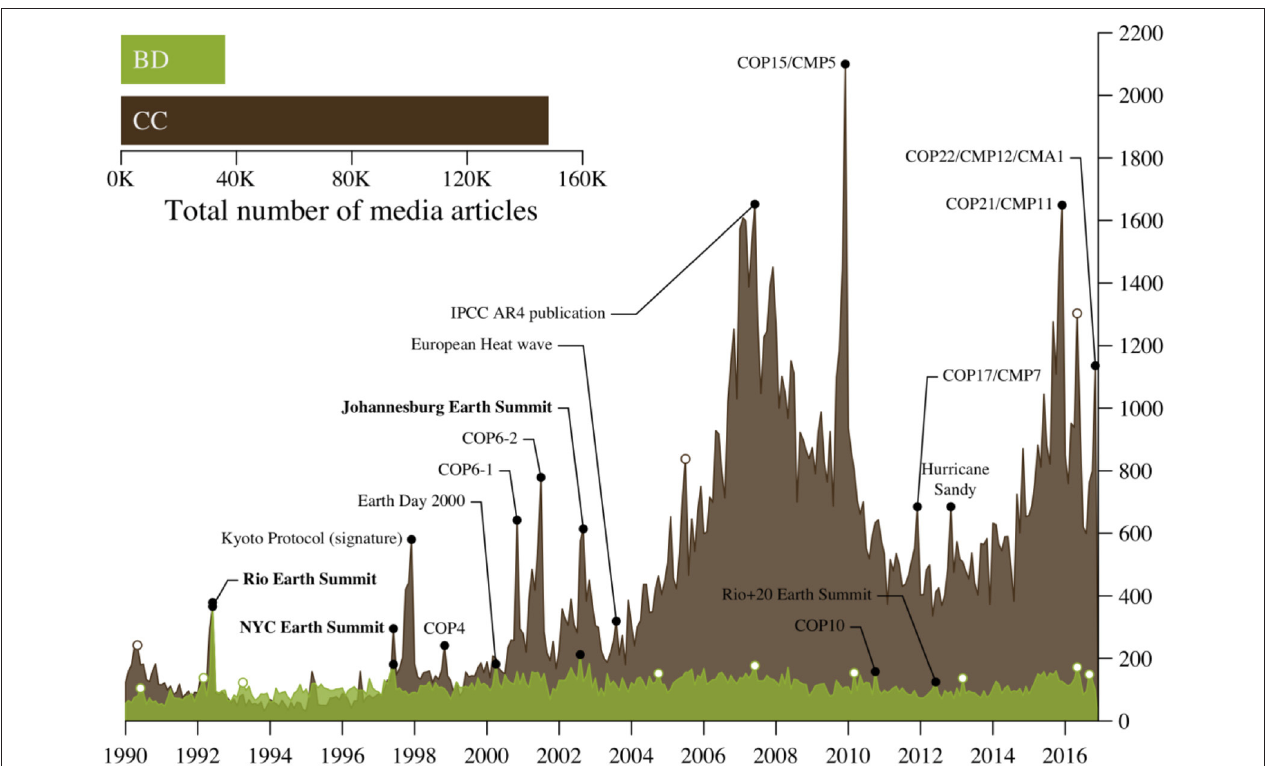
FIGURE 2 | Number of newspaper articles published per month on biodiversity (green) or climate change (brown) issues in US, Canada, and UK. Detected peaks (plain dots) and associated events are shown. Peaks without associated events (empty dots) could not be associated with a priori events. Events that embraced both CC and BD issues are written in